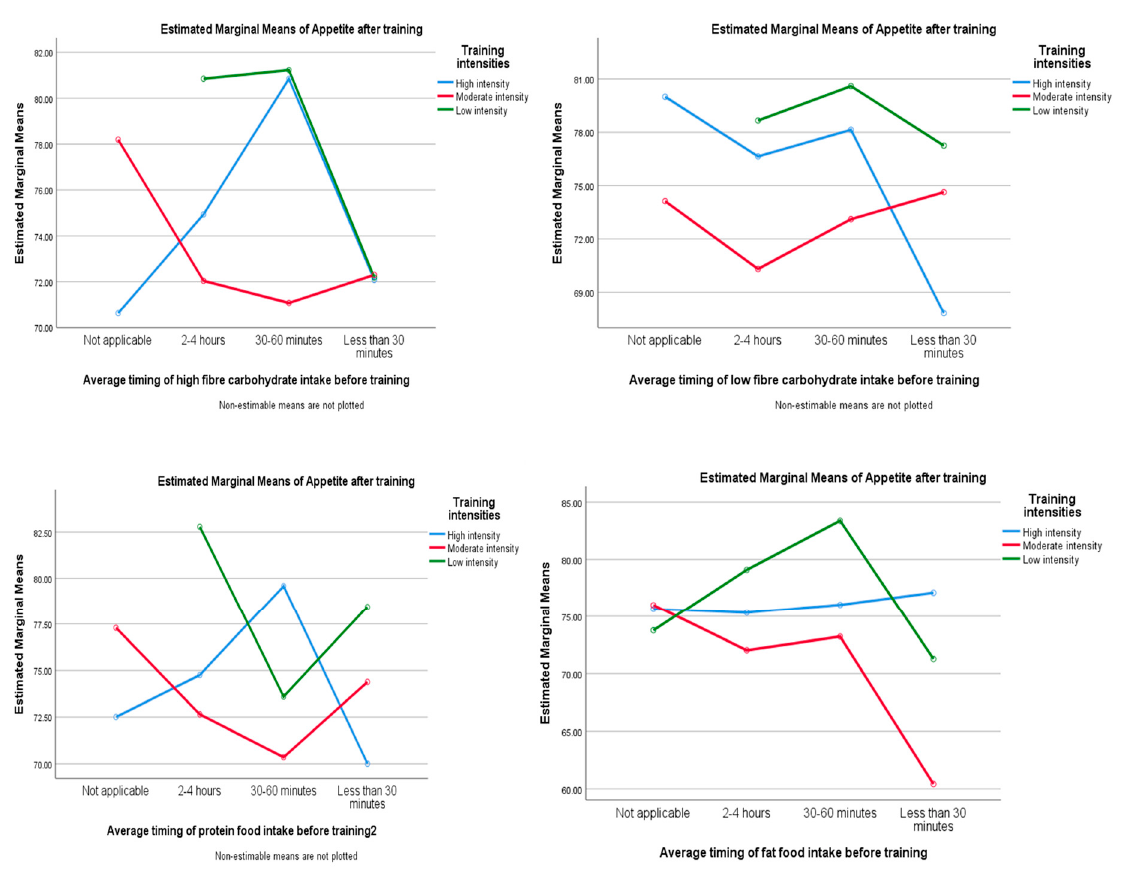
protein, and fat, especially 30–60 min before different resistance training intensities; how- ever, this suppression was not statistically significant ( p > 0.05) (Figure 4).